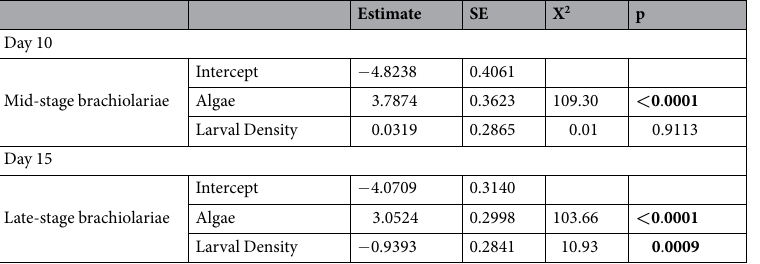
Table 2. Results of binomial linear mixed effects models testing the effect of algae cell concentrations (algae) and density of larvae (larval density) on the proportion of advanced stage (developed past early stage brachiolaria: > early brachiolaria) Brachiolaria larvae of Acanthaster cf . solaris 10 and 15 days post fertilisation. Models include an observation level random effect to account for over-dispersion. Note that intercept and slopes are for scaled data. Significance levels were tested by deviance tests ( Χ 2 and p values). The overall model